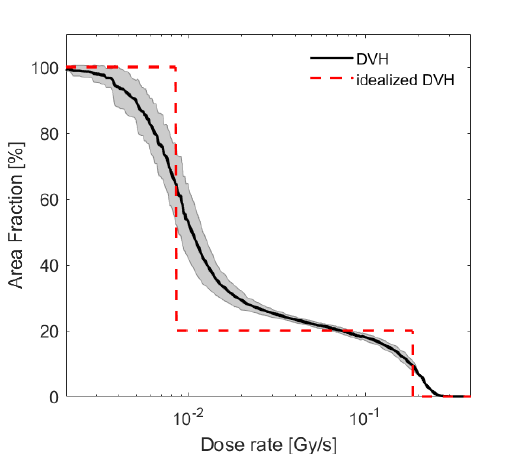
Figure 1. Dose rate volume histogram obtained as an average over 17 film measurements at different exposure duration (solid line). Shaded background corresponds to the standard deviation of these measurements per DVH bin. The dose distribution was approximated by an idealised, two-step DVH (dashed line) corresponding to the same integral dose rate of 0.044 Gy/s, a PVDR of 22 and a fraction of 80/20 % of cells receiving the valley/peak